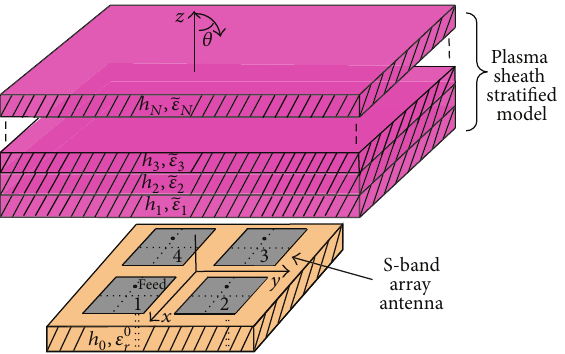
Figure 3: Plasma-covered array antenna simulation models.